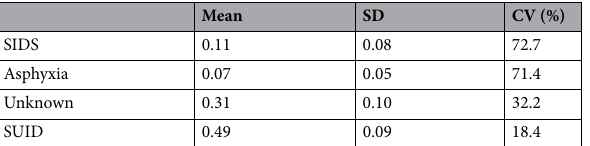
Table 1. The variability in the diagnosis of the three SUID diagnostic subcategories. The infant mortality rate per 1000 live births was calculated for 47 prefectures in Japan between 2012 and 2018. The CV was calculated by the SD by the mean. CV, coefficient of variation; SD, standard deviations; SIDS, sudden infant death syndrome; SUID, sudden unexpected infant